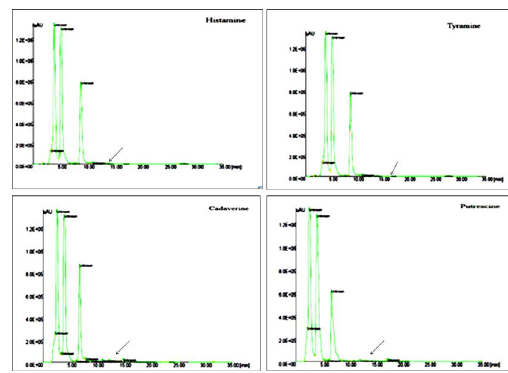
Fig. 7. HPLC Chromatogram of standard BAs Peak retention time at 17.1: Tyramine, 13.4: Putrescine, 14.1: Cadaverine, 14.9: Histamine